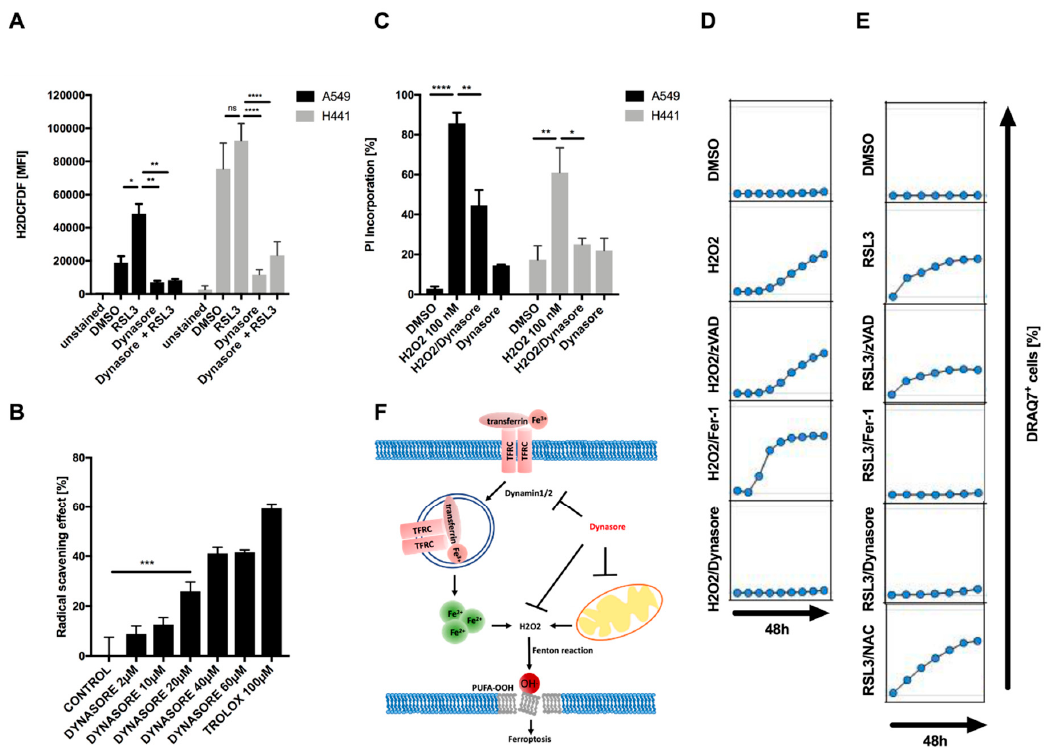
Figure 4. Dynasore functions as a broadly active radical scavenger. ( A ) Indicated cell lines were treated with DMSO, erastin (10 µ M), dynasore (80 µ M) or both for 16 h and 48 h, respectively. During the last 30 min H2DCFDF was added at 20 µ M to each well. Mean fluorescence intensity (MFI) was quantified by flow cytometry. ( B ) Dynasore (2–60 µ M) and trolox (100 µ M) were incubated with DPPH (100 µ M) for 30 min in the dark, then absorbance was measured at 517 nm to determine the radical scavenging activity. ( C ) Cells as in A were treated with DMSO, H 2 O 2 (100 nM), Dynasore (80 µ M) or both for 48 h. Cell death was determined by propidium iodide (PI) uptake and flow cytometry. ( D , E ) A549 cells were treated with DMSO, H 2 O 2 (100 nM) or RSL3 (1 µ M) alone or in combination with zVAD (20 µ M), Fer-1 (5 µ M), dynasore (80 µ M) or NAC (1.5 mM). Images were acquired every 8 h for 48 h. Dead cells were quantified as % DRAQ7 + cells using the IncuCyte image analysis software. ( F ) Schematic overview of proposed mechanism of dynasore-mediated inhibition of ferroptosis. All data are means +/ − SEM of three independent experiments or representative images where applicable. * indicates p < 0.05; ** indicates p < 0.01; *** indicates p < 0.001; **** indicates p < 0.0001; ns indicates non-significant di ff